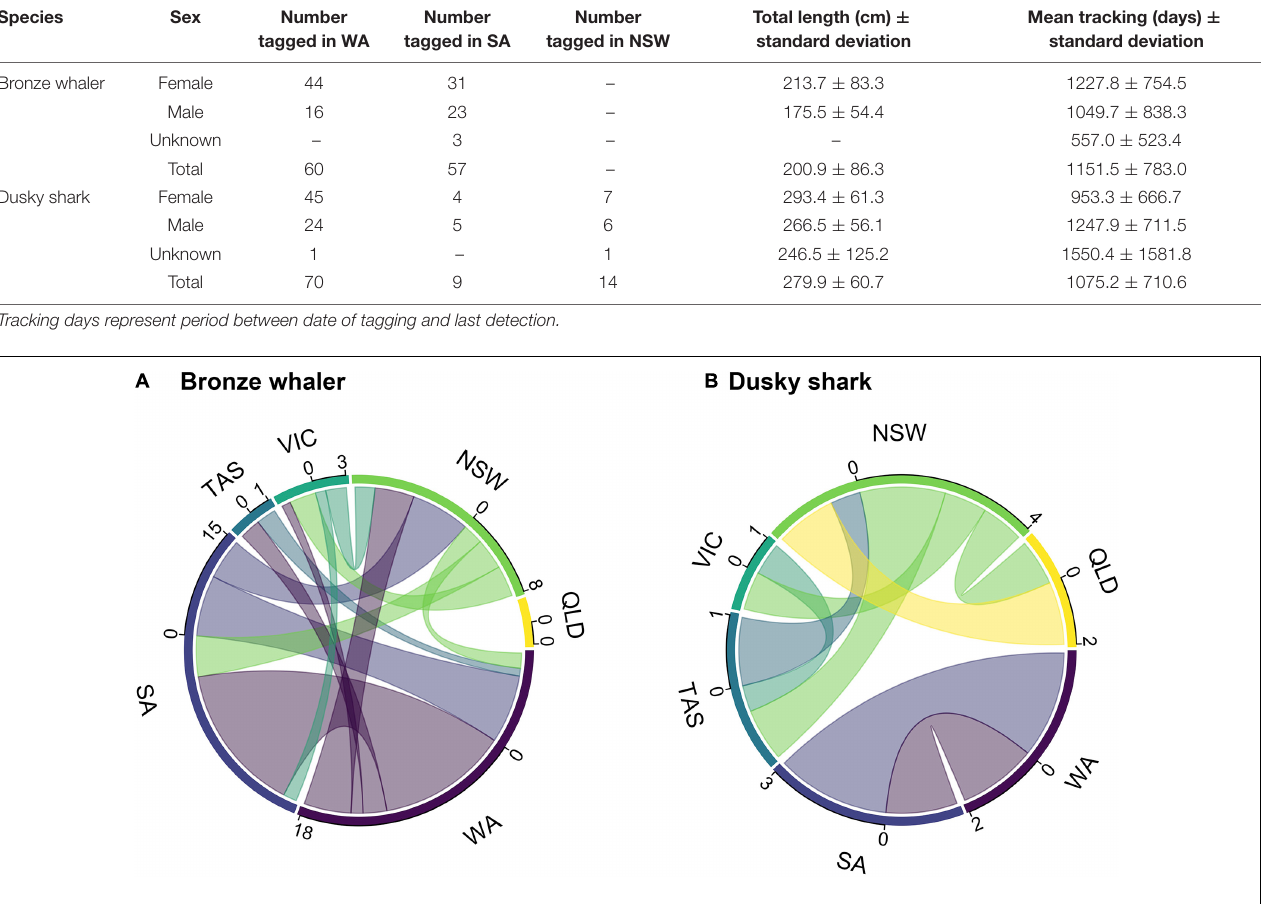
FIGURE 2 | Connectivity plots of (A) bronze whalers and (B) dusky sharks, showing the number and direction of outgoing movements (numbers = observed inter-state movements) from each state (color scale; WA, Western Australia; SA, South Australia; TAS, Tasmania; VIC, Victoria; NSW, New South Wales; and QLD,